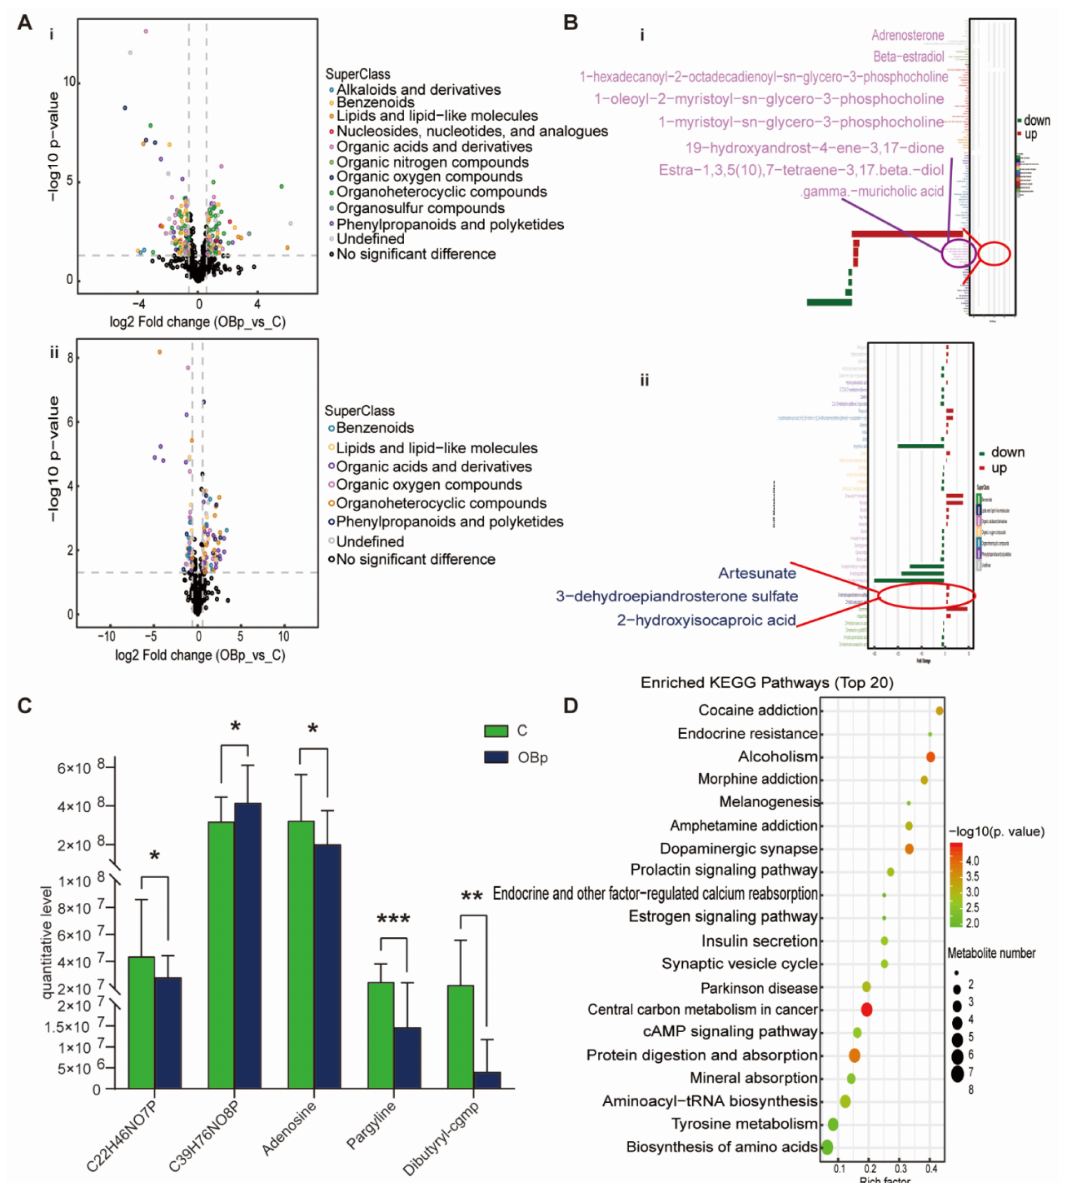
Figure 4. Analysis of differential metabolites between OBp vs. C. ( A ) Volcanic maps of positive (i) and negative (ii) ion modes. Points on the right half of volcano plot represent up-regulated metabolites satisfying FC > 1.5, p < 0.05, and points on the left half represent down-regulated metabolites satisfying FC < 0.67, p < 0.05, and black points on behalf of non-differential metabolites. ( B ) (i,ii) Bar graphs of the positive and negative ion modes. The abscissa indicates the fold change (FC). Red bars on behalf of up-regulated metabolites satisfying FC > 1, p < 0.05, green bars on behalf of down-regulated metabolites satisfying FC < 1, p < 0.05. The ordinate represents significantly distinctive metabolites. Local enlarged view for lipids and lipid-like molecules. ( C ) C22H46NO7P: 1-myristoyl-sn-glycero-3- phosphocholine. C39H76NO8P: 1-hexadecanoyl-2-octadecadienoyl-sn-glycero-3-phosphocholine. Differential metabolites unique to the to the OBp group. (* p < 0.05, ** p < 0.01, *** p < 0.001). ( D ) KEGG pathway enrichment bubble diagram. The vertical axis represents the KEGG metabolic pathway, and the horizontal axis represents the rich factors (the ratio of the number of differential metabolites to the number of annotated metabolites in this pathway). The redder the circle color, the smaller the p -value of enrichment analysis and the higher the channel significance